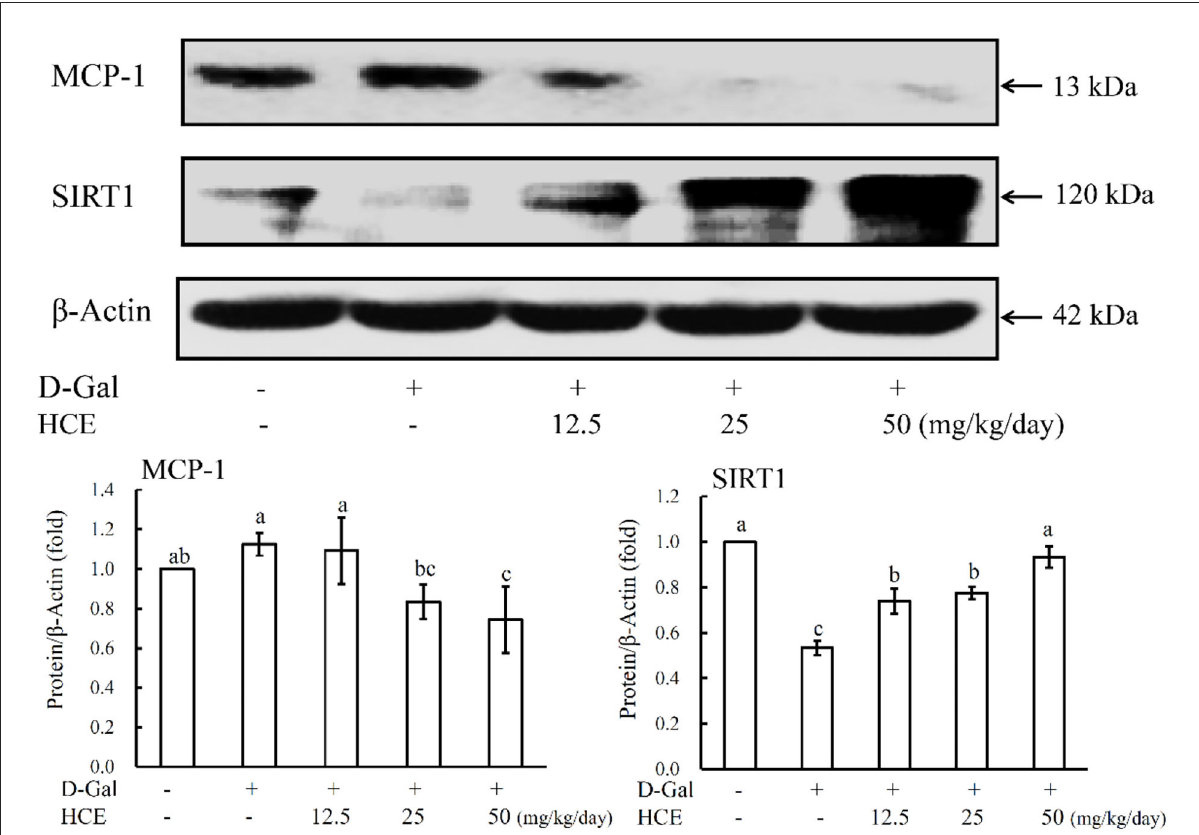
FIGURE3 Effects of herbal chicken essence (HCE) on the expression of MCP-1 and SIRT1 in the liver tissue of D-galactose-induced aging mice. β -Actin was used as a loading control. Values are expressed as means ± SD ( n = 6). The bar having the same letter was not significantly different at P < 0.05 as analyzed by Duncan’s multiple range